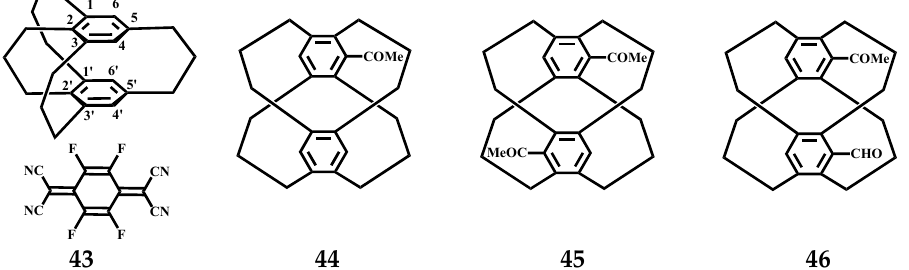
Figure 20. The structures of [3 4 ]CP-TCNQ-F4 complex 43 and the monoacetyl and diacetyl com- pounds 44 , 45 and 46 .